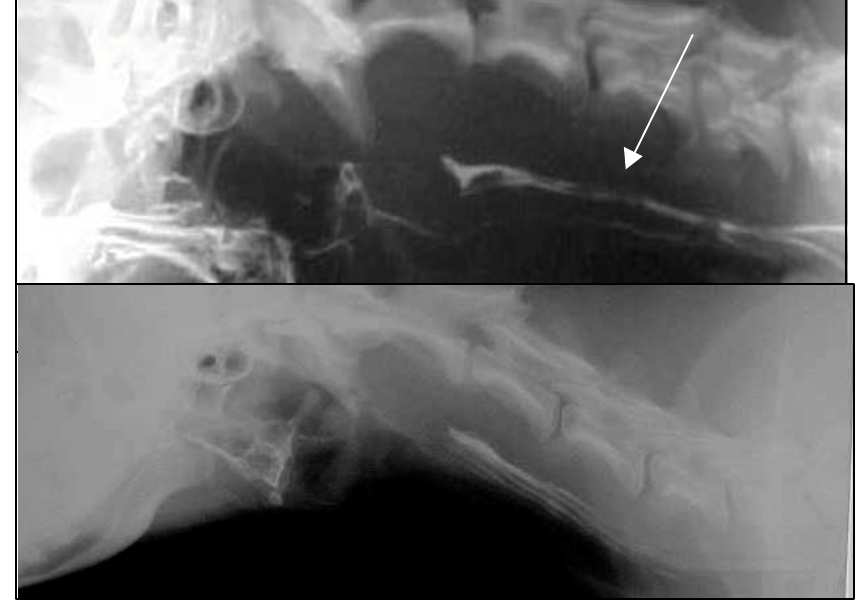
FIGURA 4 - Esofagograma: esôfago com estenose (acima) e após a correção